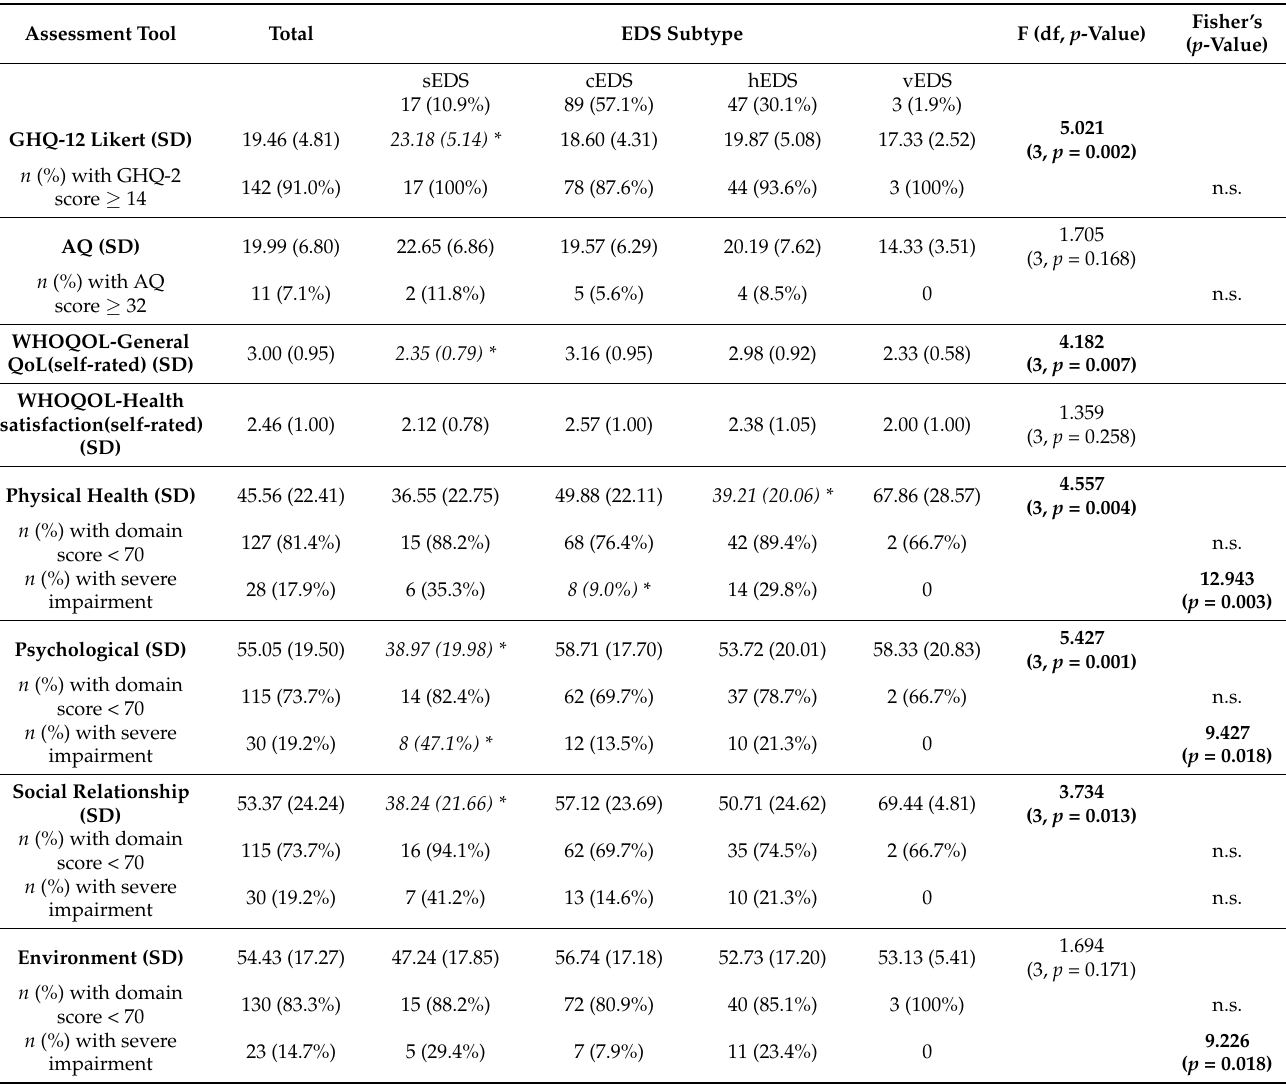
Table 1. Mean GHQ-12, AQ, and WHOLQOL-BREF scores with individuals exceeding the cut-off. Assessment